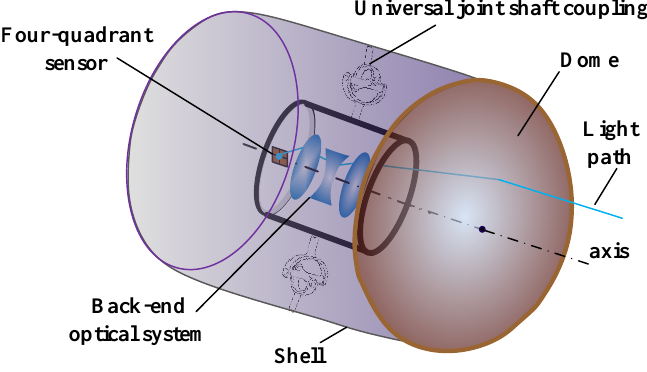
Figure 1. Airborne guided optical layout.